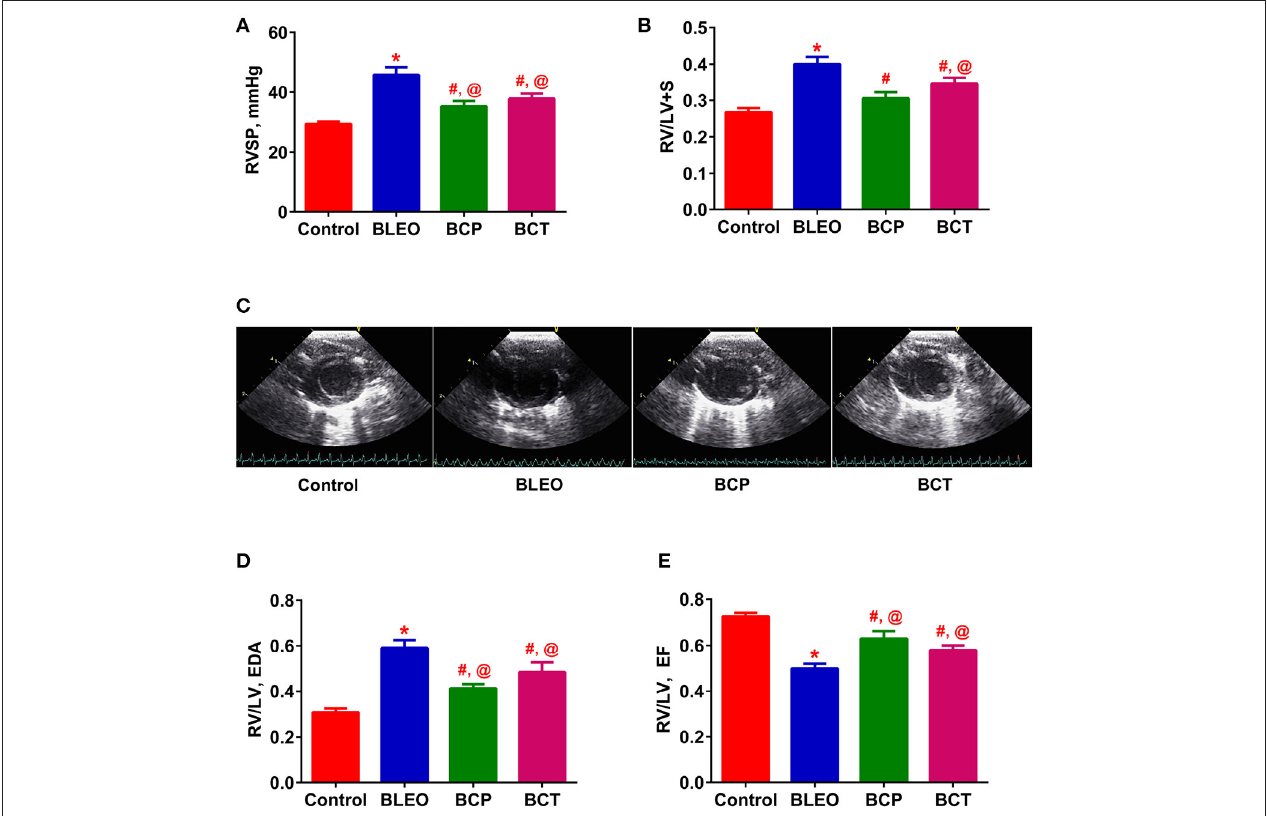
FIGURE 3 | C21 treatment attenuates the right ventricular remodeling in BLEO animals. (A,B,D,E) Summary data showing the improvement of RVSP, RVH, RV/LV EDA, and RV/LV EF in BLEO animals in presence of C21. (C) Representative images of parasternal short axis view of the ventricles on Day-14. Data represented in (A,B,D,E) are mean ± SEM ( n = 6–8). *Indicates a p -value of ≤ 0.05, comparing BLEO animals against the controls. # Indicates a p -value of ≤ 0.05, comparing BCP and BCT vs. BLEO. @ Indicates a p -value of ≤ 0.05, comparing BCP and BCT vs. control.